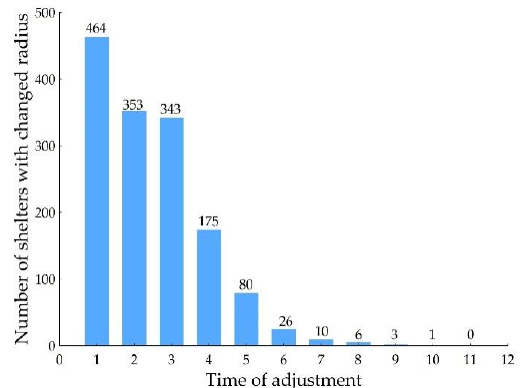
Figure 6. Emergency shelters’ adjustment number histogram.